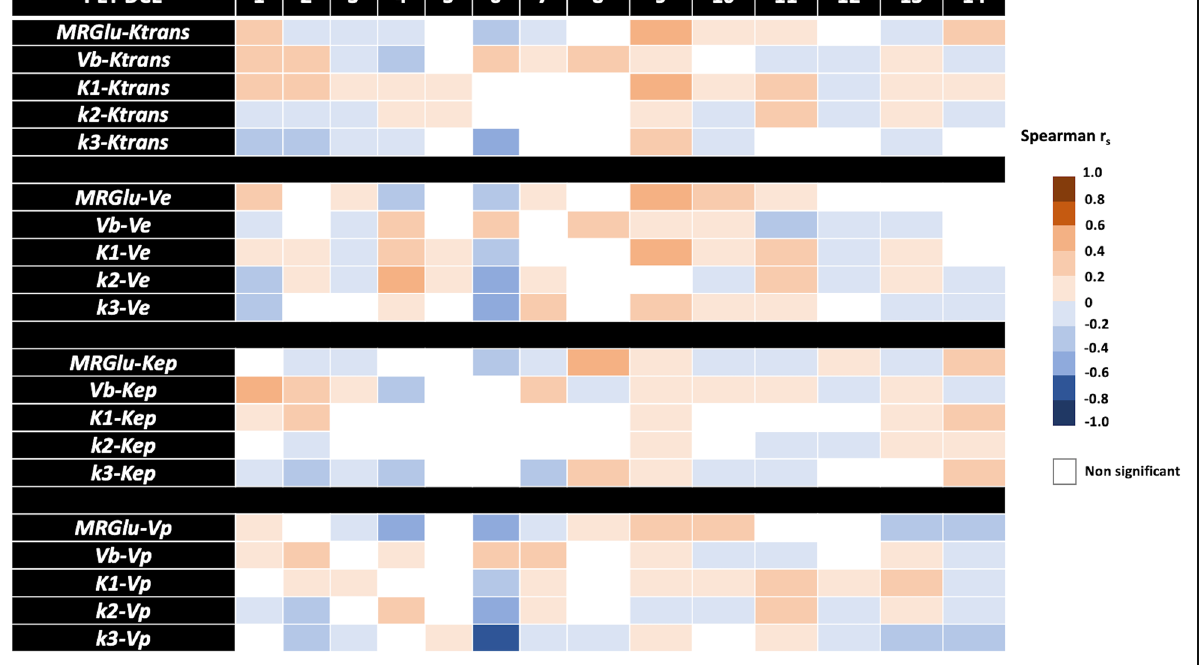
Fig. 5 PET-DCE Spearman correlation. For each tumor (1 to 14), all the PET-DCE correlation pairs are